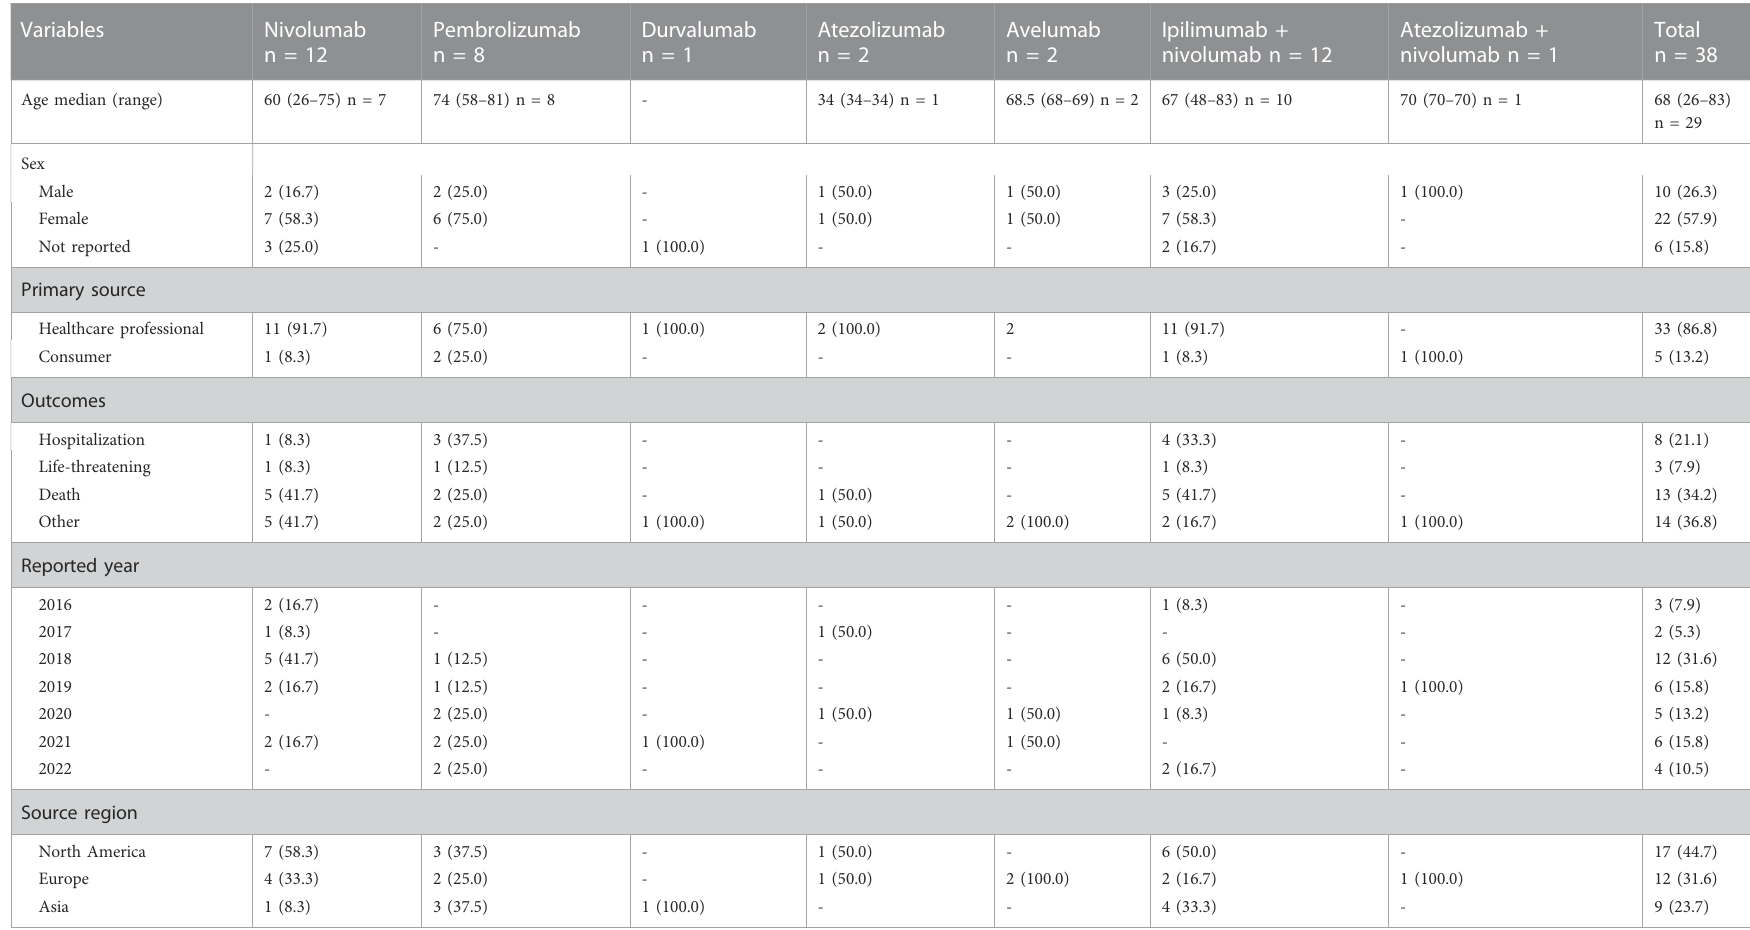
TABLE 3 Clinical characteristics of patients with immune checkpoint inhibitor-induced aplastic anaemia collected from the FAERS database (January 2011 to June